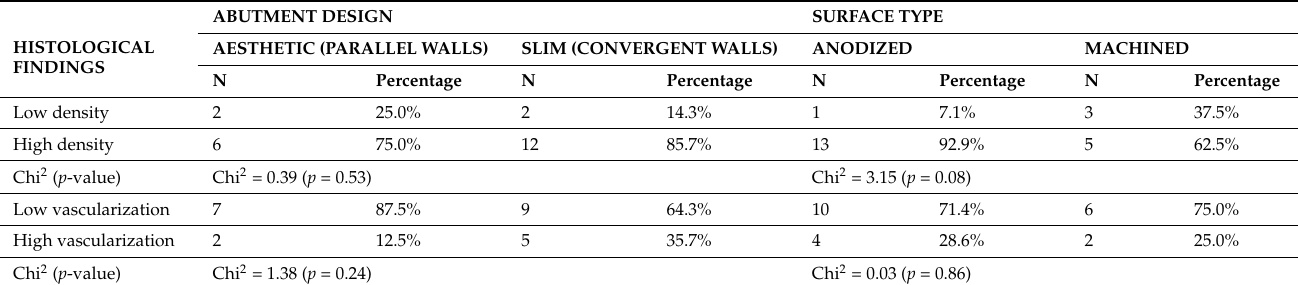
Table 3. Comparison by 2 × 2 chi-square tests of the effect of either abutment design (parallel vs. convergent) or the surface type (anodized vs. machined) on the density and vascularization of the gingival